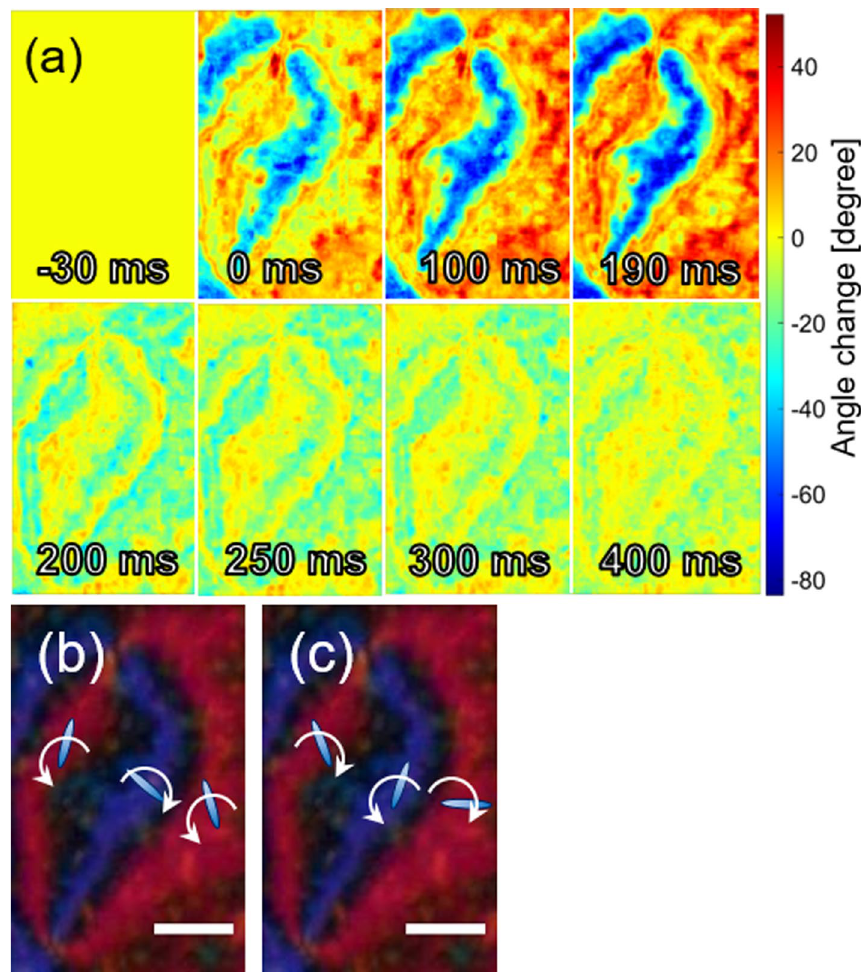
Figure 5. (a) A time sequence of the orientation angle change under the UV light irradiation. The UV light was irradiated from 0 to 200 ms. The difference from the original orientation angle obtained in Fig. 3 is shown. (b,c) The summarized drawings of the change in the orientation angle at each brush (b) during and (c) after light irradiation (prepared by PowerPoint